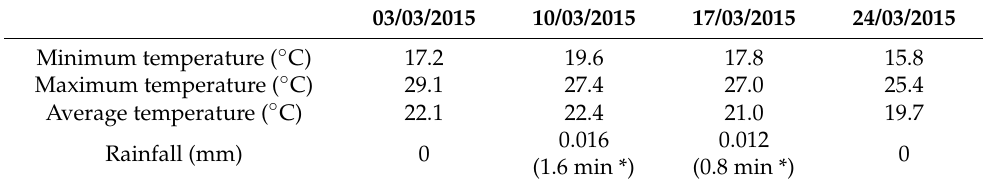
Table A1. Climatic conditions of mosquito collection dates (DD/MM/YY).